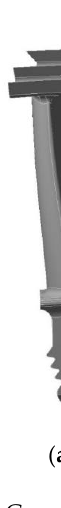
Figure 3. ( a ) Generic model of the turbine blade; ( b ) sectional drawing of the turbine blade.